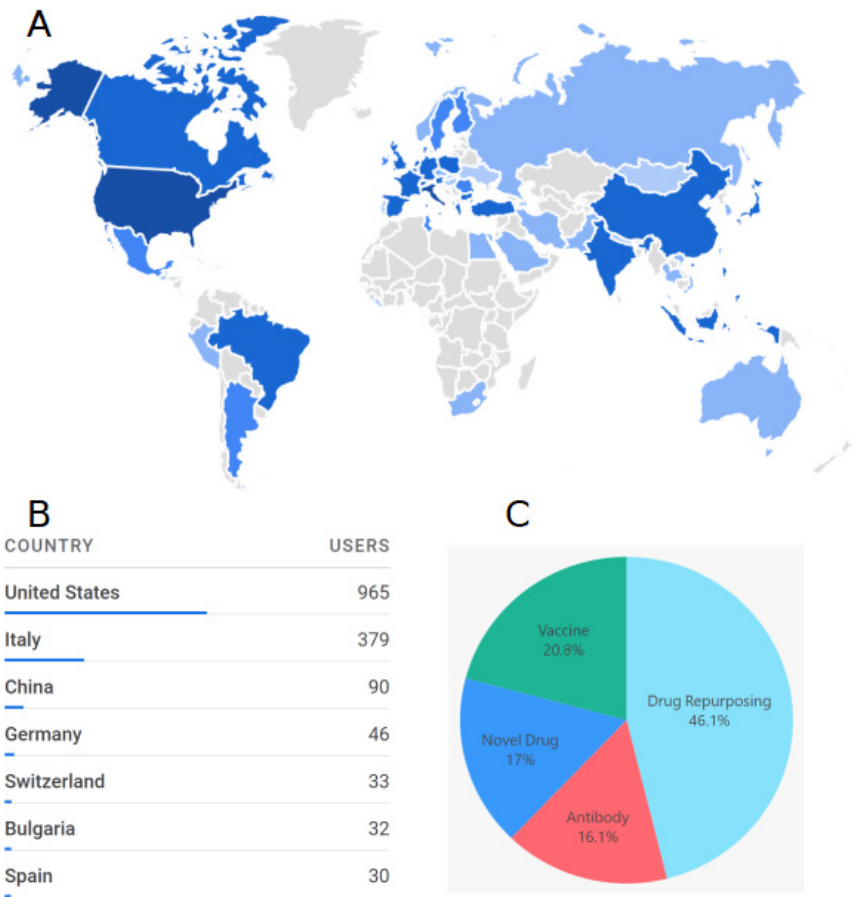
Figure 6. Registered users of the Spike Mutants website. ( A ) Country of origin of the users; ( B ) First seven countries by number of users. ( C ) Declared the main research objective of the users.